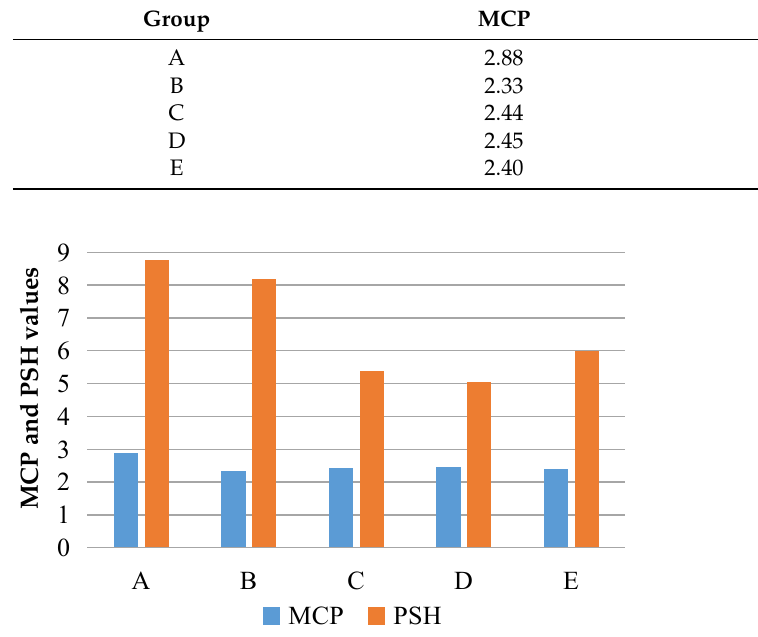
Figure 17. Comparative analysis of MCP and PSH values for the desert sand and ordinary sand.